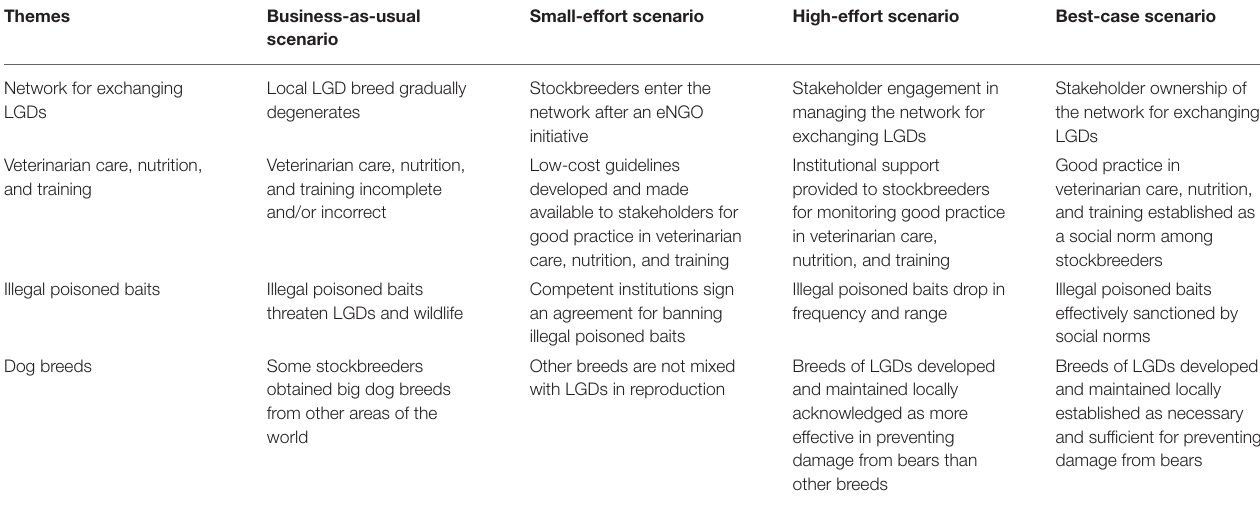
TABLE 9 | Template for participatory scenario development for